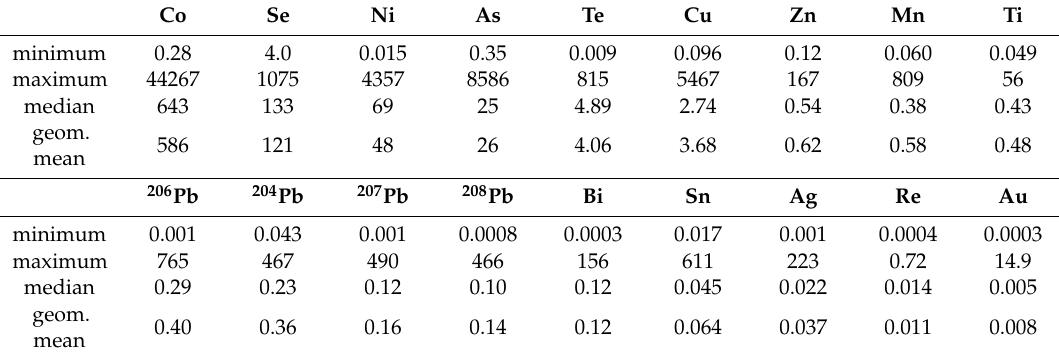
Table 1. Summary of the trace element composition of pyrite (in ppm) for the imputed N = 1501 dataset. Elements are arranged in order of decreasing median